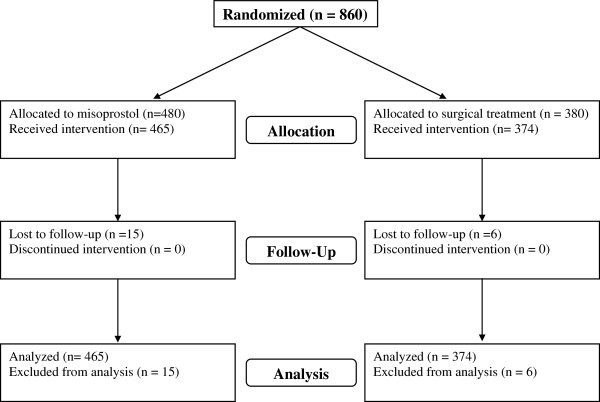
Study flowchart.